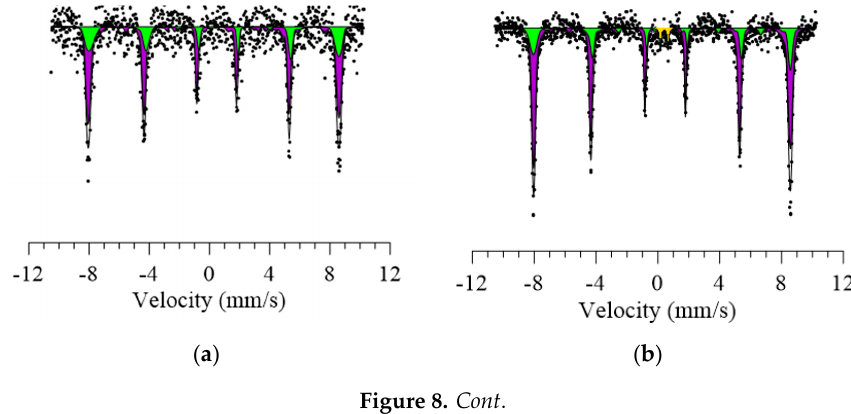
Table 2. Magnetic characteristics